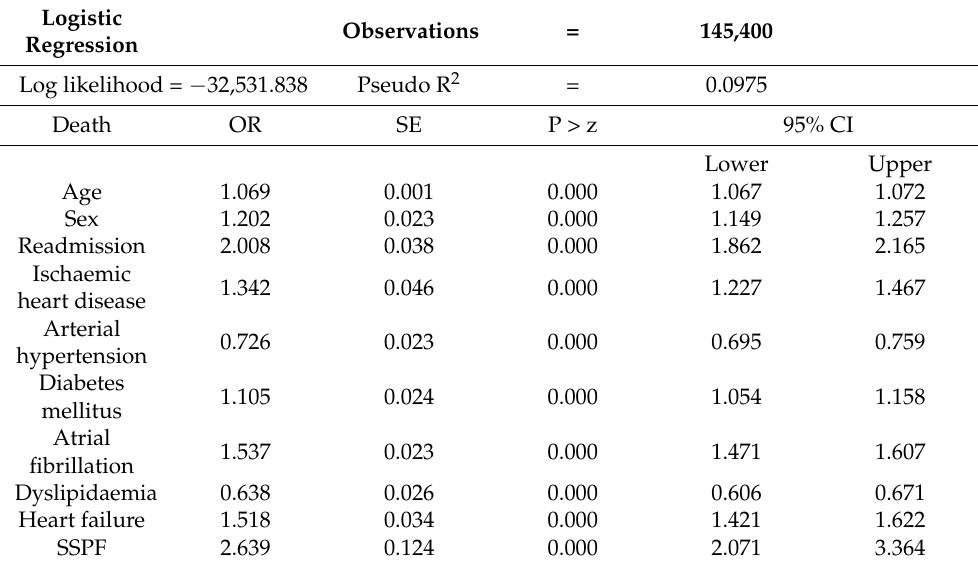
Table 3. Logistic regression model to predict mortality. Training